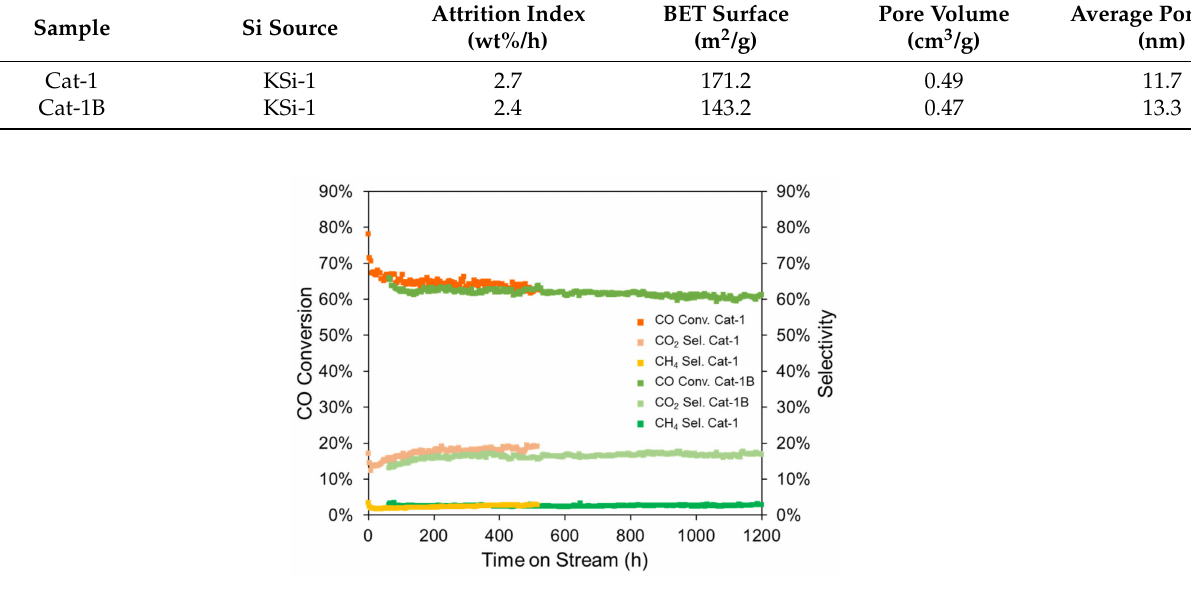
Figure 14. Reaction performance of Cat-1 and Cat-1B in slurry bed. Table 12. Fischer–Tropsch synthesis performances of Cat-1 and